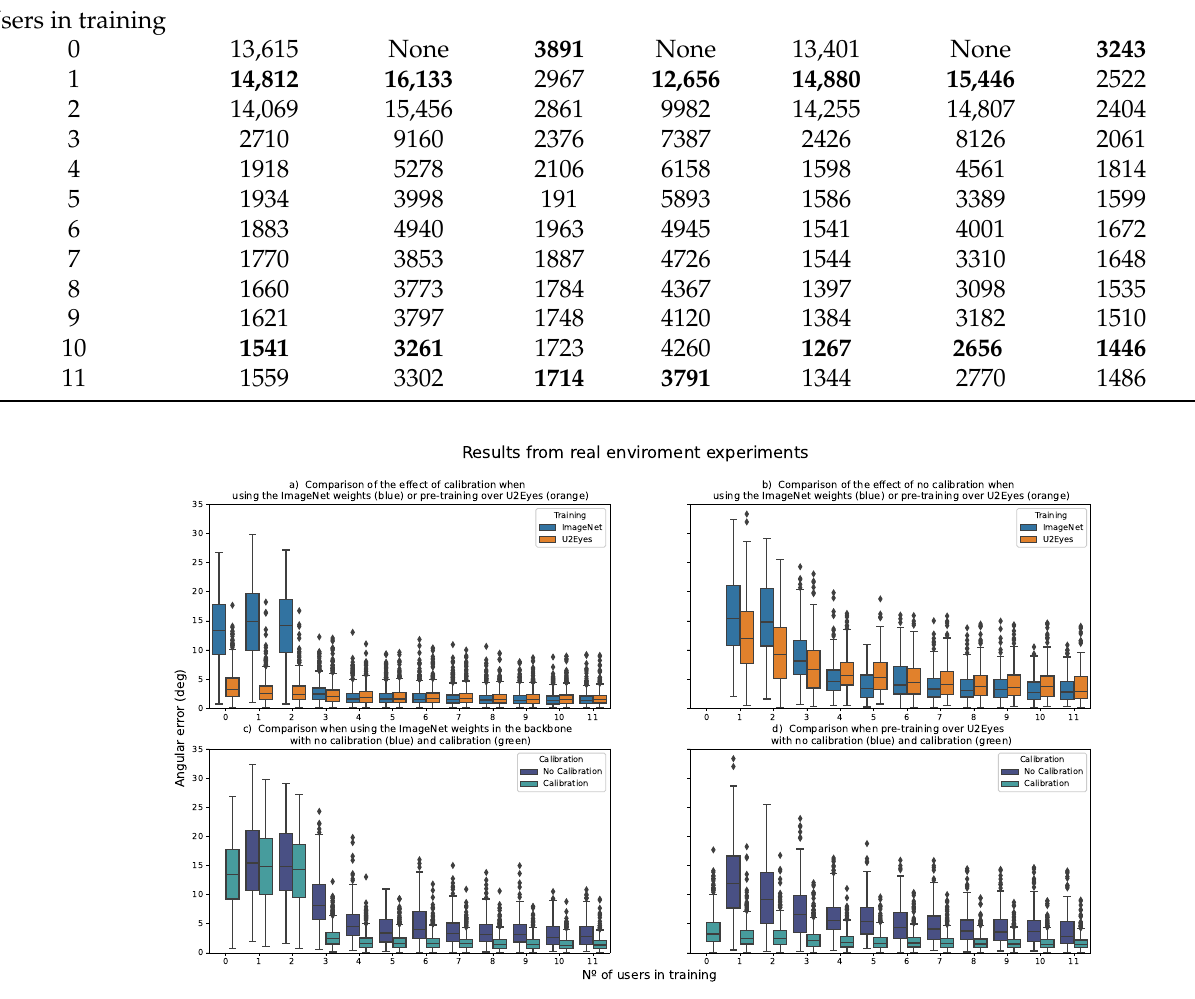
Figure 9. Results of the experiments from the real environment. ( a ) Original experiments from the paper [24]. Training with calibration. We can observe how the model pretrained over U2Eyes outperforms the ImageNet model when the number of users in training is small. ( b ) Results obtained when training the networks (U2Eyes and Imagenet) without calibration. Same configuration as in the original paper but without calibration. In this case, the advantage of pretraining over U2Eyes when the number of users in training is small is not as significant as in the previous case. ( c ) Comparison of the results obtained from the original experiment (calibration) and the new experiment (no calibration) when training over the model with the ImageNet weights. ( d ) Comparison of the results obtained from the original experiment (calibration) and the new experiment (no calibration) when training using the model pretrained over